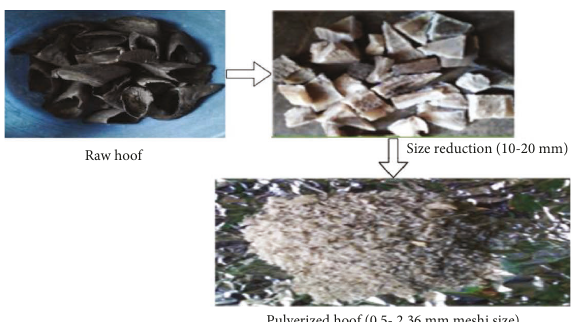
Figure 1: Cattle hoof pulverization procedure.